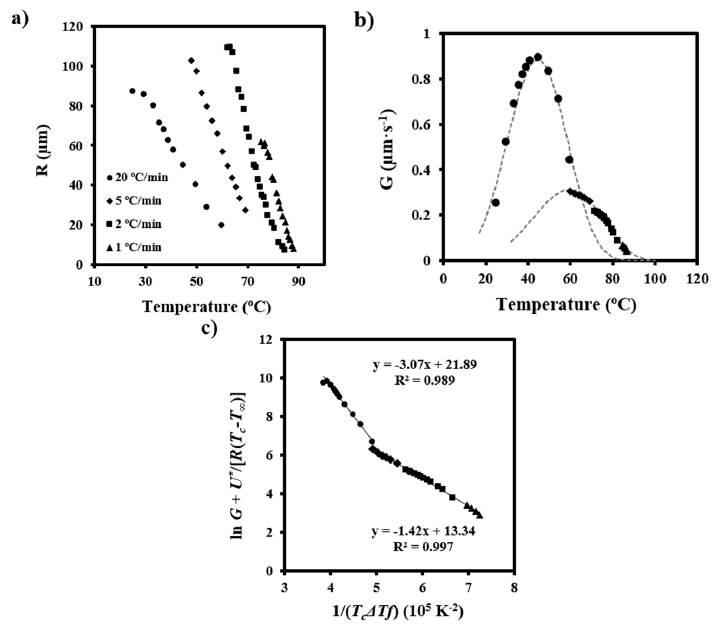
Figure 7. ( a ) Variation in spherulite radius with temperature during heating at the indicated rates; ( b ) Spherulitic growth rates determined by the equations deduced for the heating runs. Theoretical curves are also drawn (dashed lines) for comparative purposes; ( c ) Plot of ln G + U */ R ( T c − T ∞ ) versus 1/ T c ( Δ T ) f to determine the K g secondary nucleation parameters of PDO.